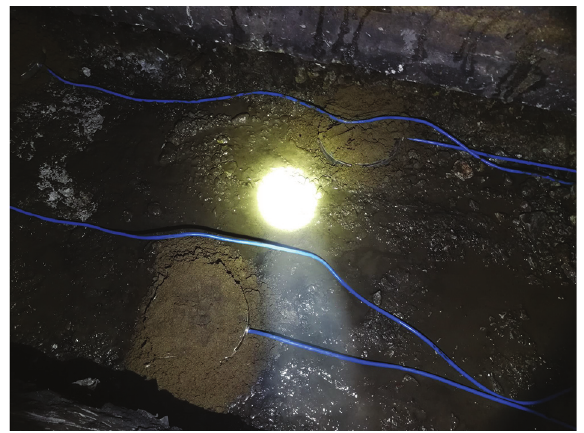
Figure 4: Installation of dynamic stress sensors.